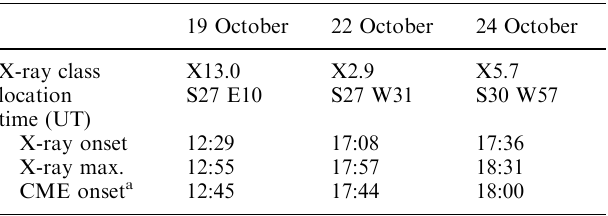
Table 1. Characteristics of the 19, 22, 24 October solar flares; a earliest onset of type II and/or IV radio bursts (SGD)